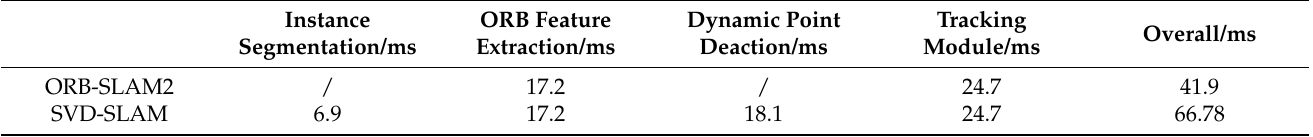
Table 4. Test results of image processing time for each